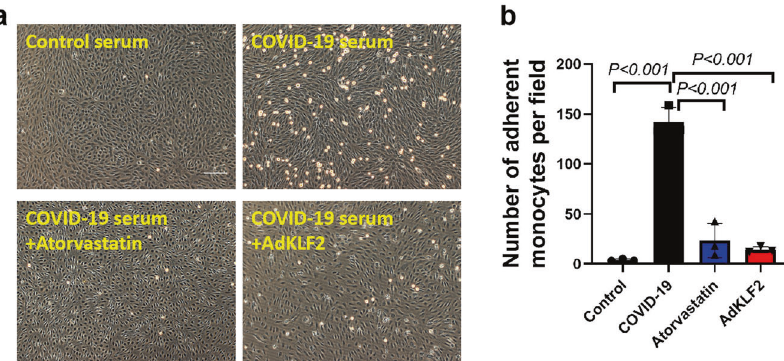
Fig. 6 Genetic and pharmacological activation of KLF2-reduced monocyte adhesion to patient-serum-treated endothelial cells. a Human pulmonary microvascular endothelial cells (HPMECs) were treated with control serum or COVID-19 serum for 24 h before THP-1 monocyte adhesion assay was performed. Nonadherent cells were washed and photographs of adherent monocytes were taken, N = 3. Scale bar = 50 µm. b A quanti fi cation of adherent monocytes as described in a , N =